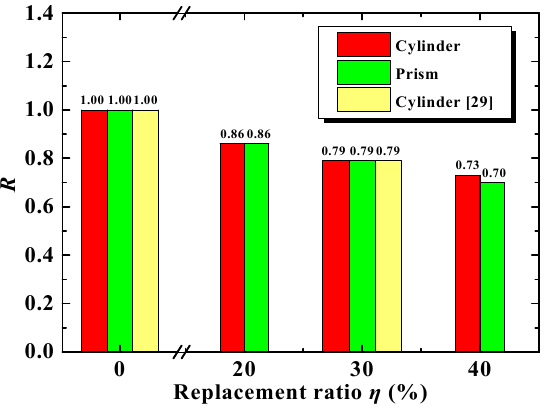
Figure 11. R and replacement ratio of DCLs.